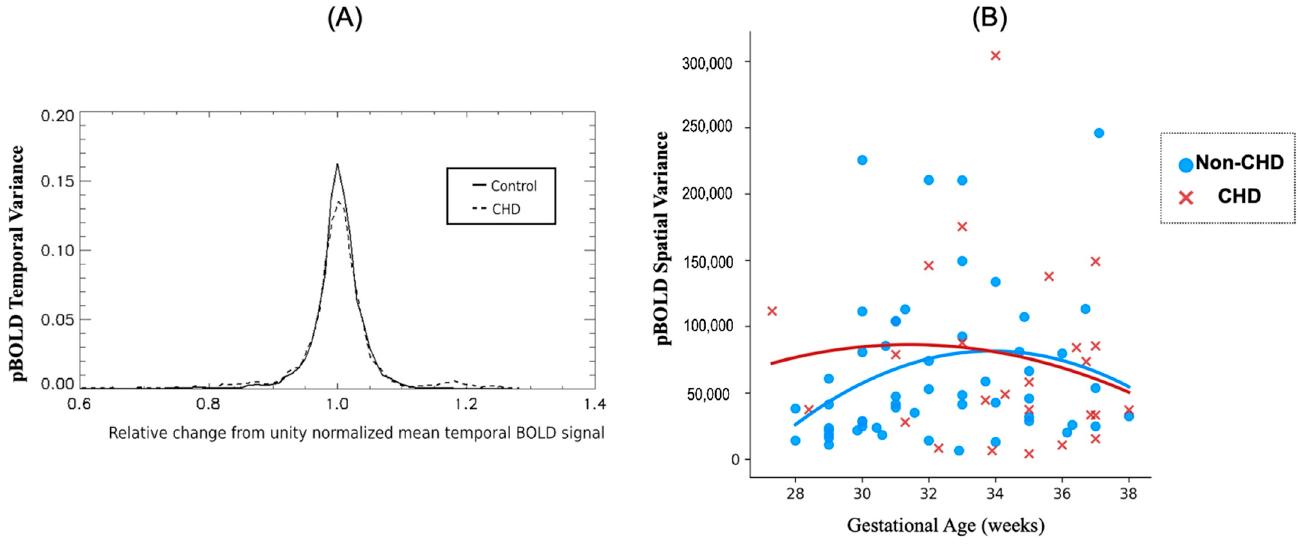
Figure 2. Spatiotemporal characteristics of intrinsic pBOLD in CHD and non ‐ CHD cases: ( A ) Histogram characteristics of pBOLD temporal variance between CHD and non ‐ CHD groups: while the distribution of pBOLD temporal variance between the two group is not different (K ‐ S test, p value = 0.182), the pBOLD temporal variance is reduced in the CHD group compared to non ‐ CHDs, corrected for gestational age and; ( B ) Regression plot showing significant interaction of CHD status on the relationship between gestational age and pBOLD spatial variance ( p = 0.004).